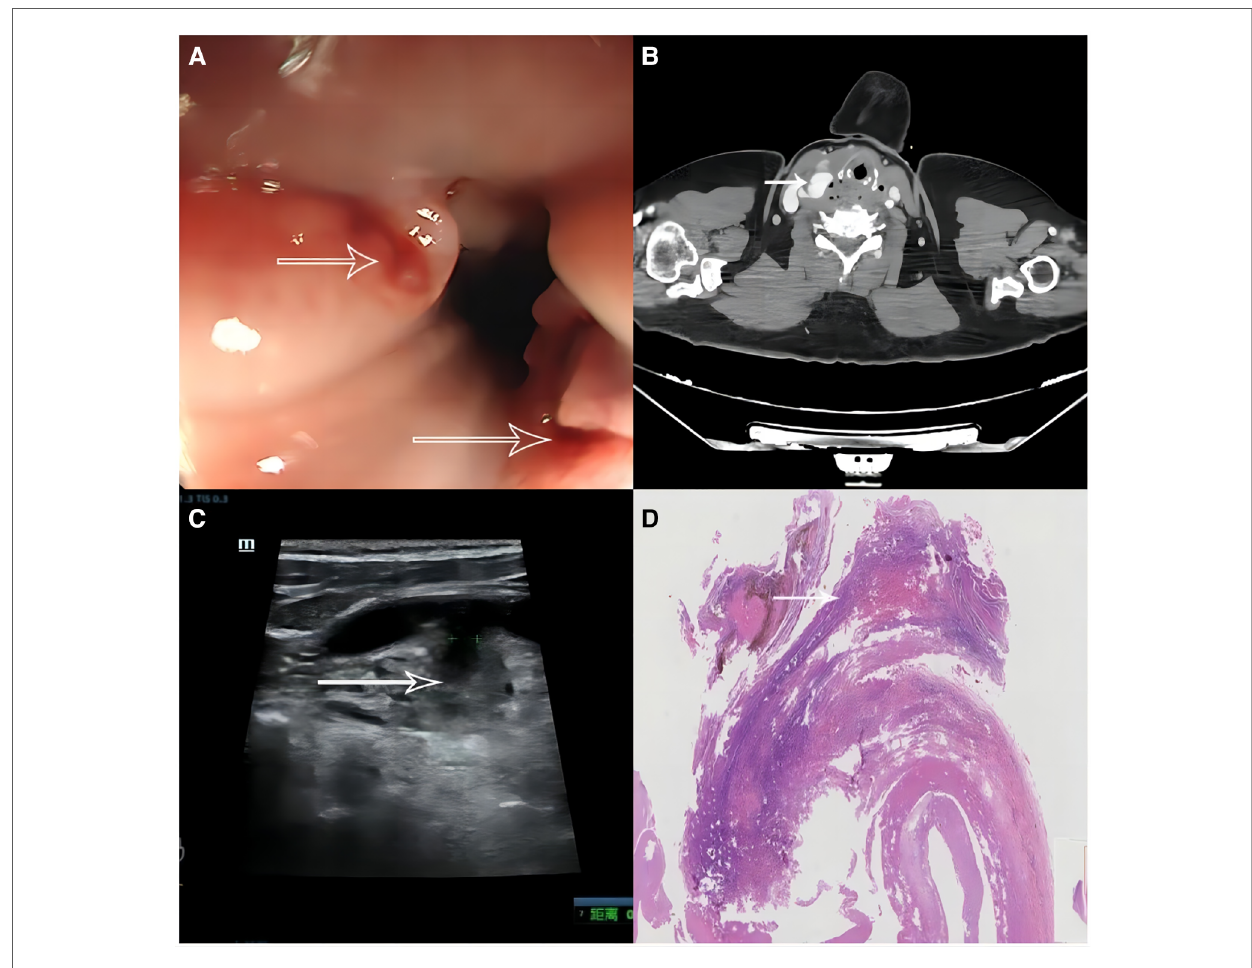
FIGURE 1 Endoscopic and imaging studies. ( A ) Endoscopic examination revealed two lamellar mucosal lesions in the upper esophagus, located at 11 o ’ clock and 4 o ’ clock, respectively (arrows). The mucosal lesion at 4 o ’ clock was larger and deeper, with dark blood on the surface. ( B ) Contrast enhanced computed tomography scan showed a patchy enhanced shadow extending from the right cervical root to the right common carotid artery (arrow), with surrounding free air bubbles. The shadow was close to the esophageal entrance. ( C ) Ultrasonography examination revealed a 33×27 mm cystic common carotid artery pseudoaneurysm with partial thrombosis (arrow). ( D ) Postoperative histopathology report of resected fi stula tissue showed in fi ltration of in fl ammatory cells